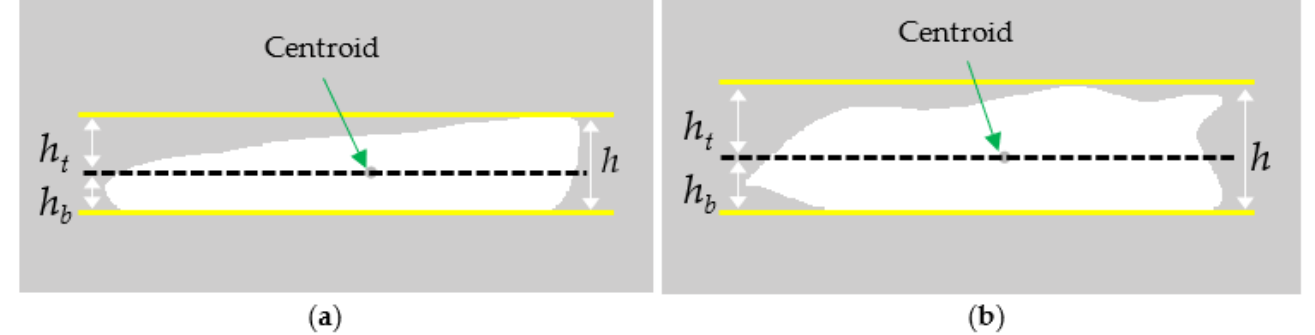
Figure 7. Height features of flat fillets for normalization of distance measure, shown on ( a ) normal fillet and ( b ) severe woody breast fillet.